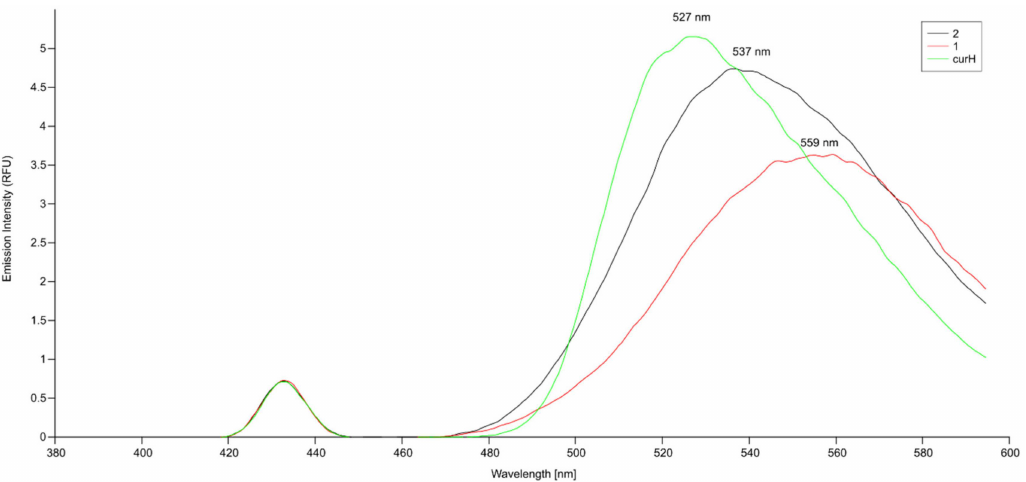
Figure 9. Emission spectra of 0.1 µ M curH, 1 , and 2 in DMSO ( λ ex = 435 nm for curH; λ ex = 431 nm for 1 and 2